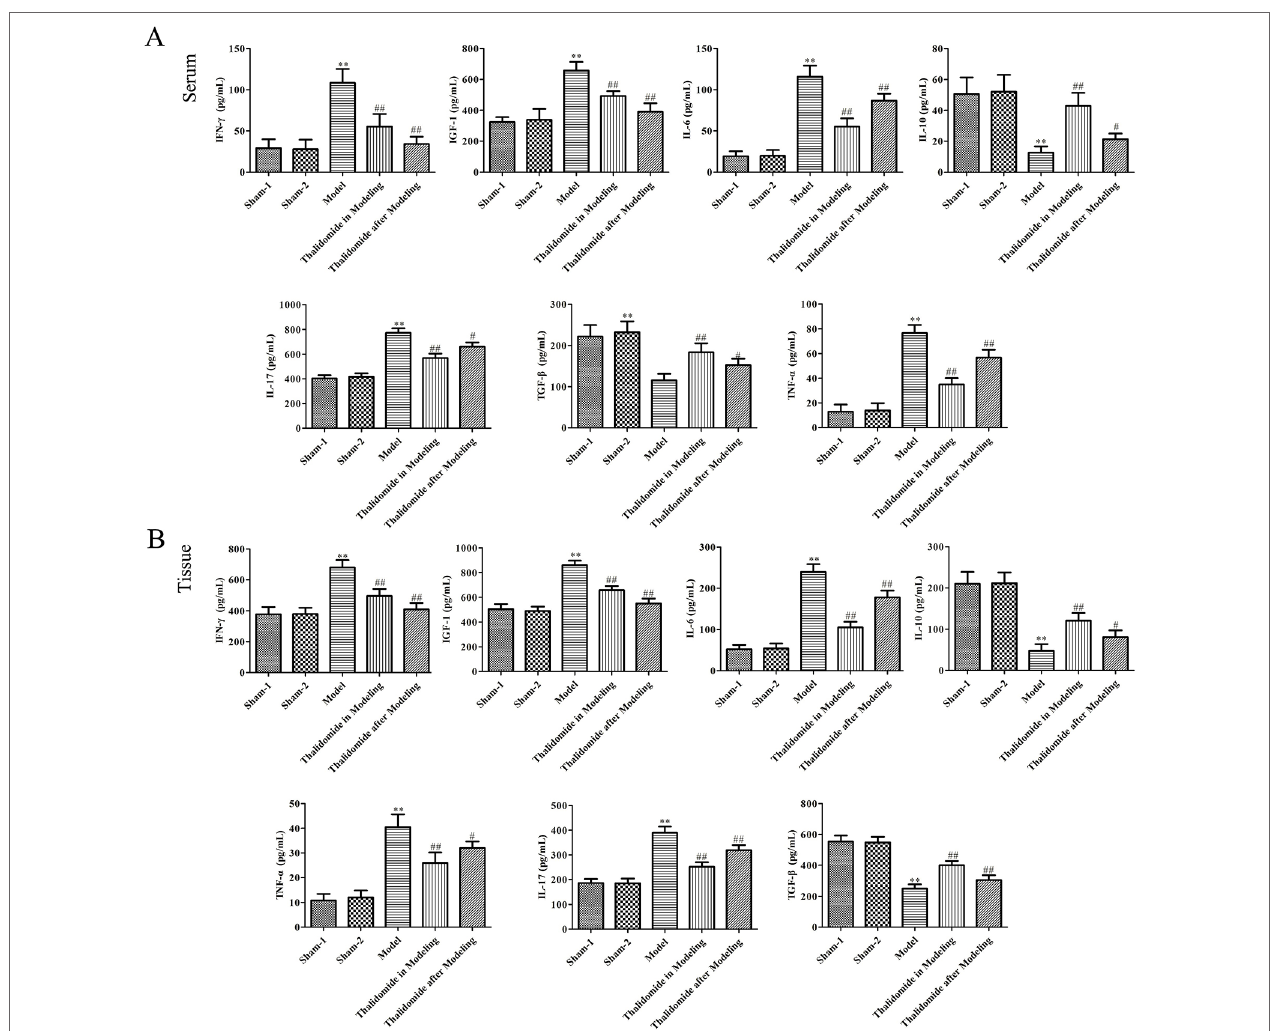
FIgURe 4 | Effects of thalidomide on the production of inflammatory cytokines in mice induced with TNBS. Thalidomide treatment could obviously inhibit production of IFN-γ, IGF-1, IL-6, IL-17 and TNF-α, and promote the production of IL-10 and TGF-β in serum (A) and colonic tissues of mice from different groups (B) . The results were expressed as the mean ± SD. ** P < 0.01 compared with sham-1 and sham-2 groups, # P < 0.05, ## P < 0.01 compared with the model group.